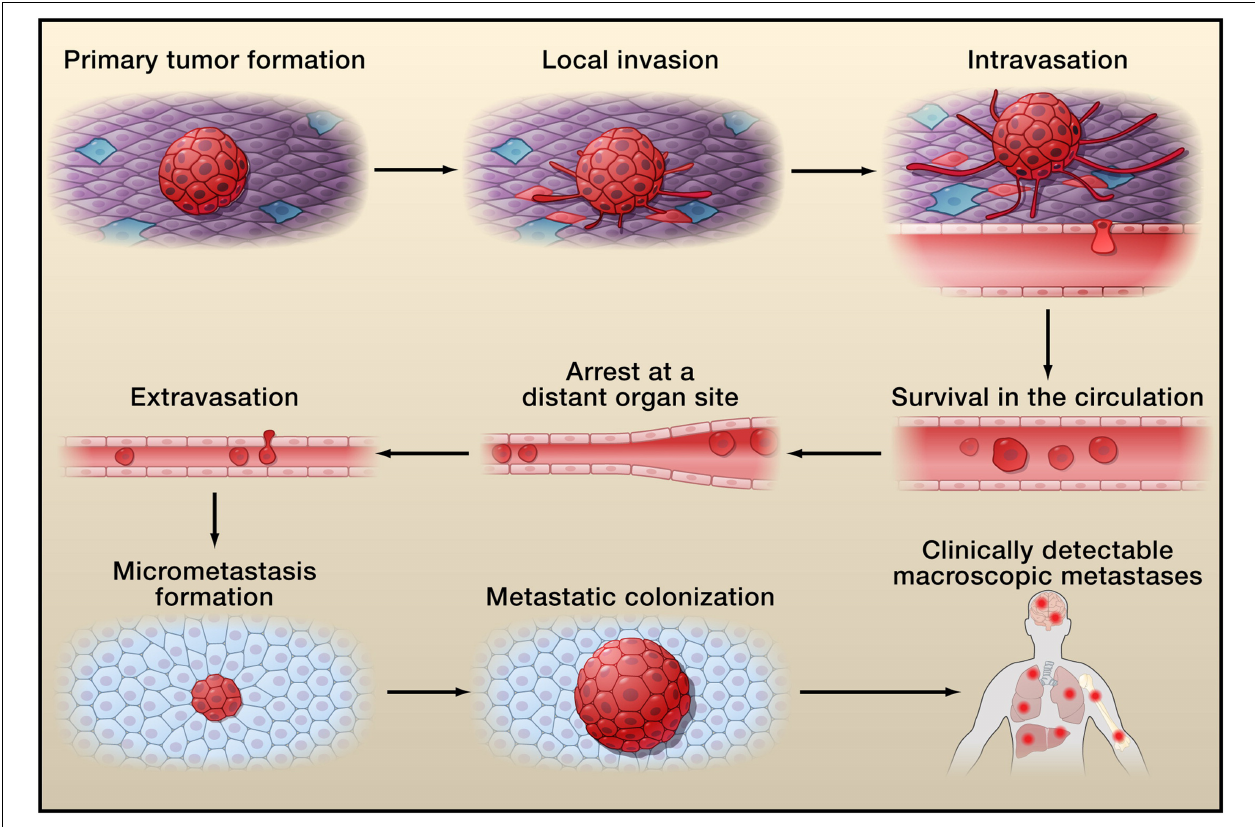
FIGURE 1 |The invasion–metastasis cascade. Tumor cells exit their primary sites of growth (local invasion, intravasation), translocate systemically (survival in the circulation, arrest at a distant organ site, extravasation), and